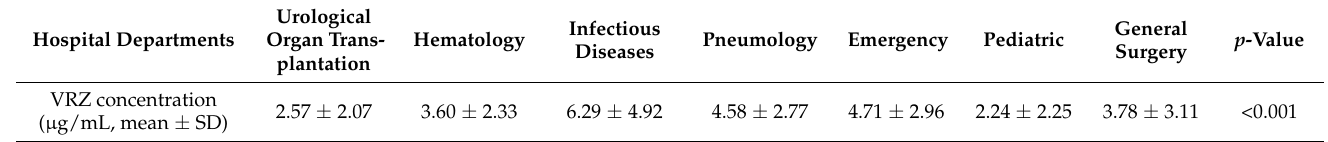
Table 2. Voriconazole trough concentration among different hospital